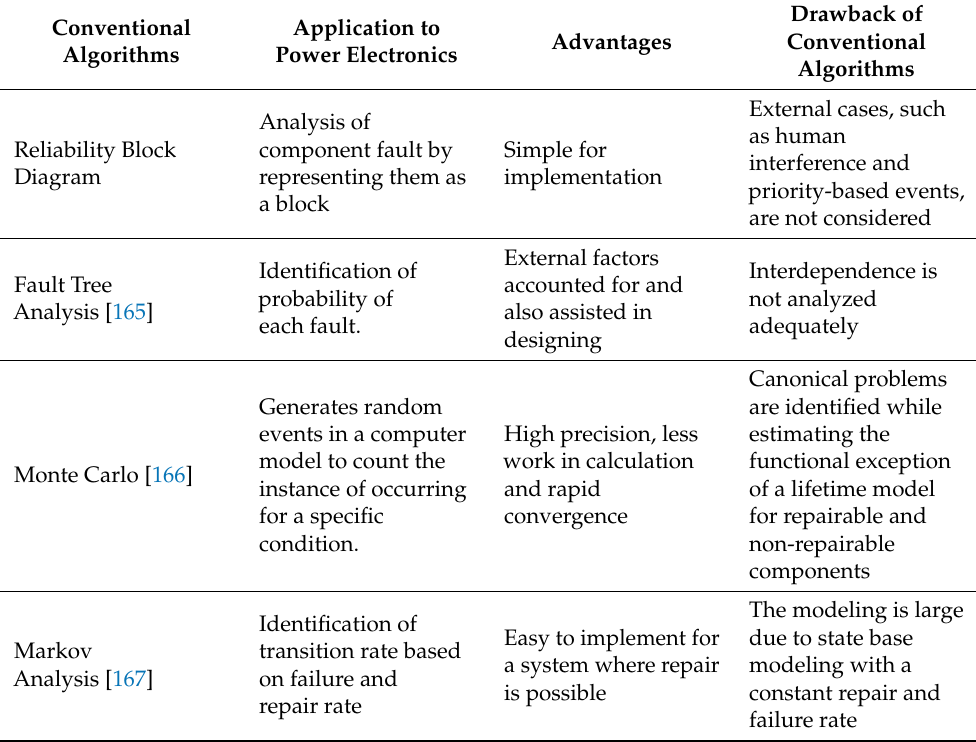
Table 10. Comparison of convention algorithm for lifetime